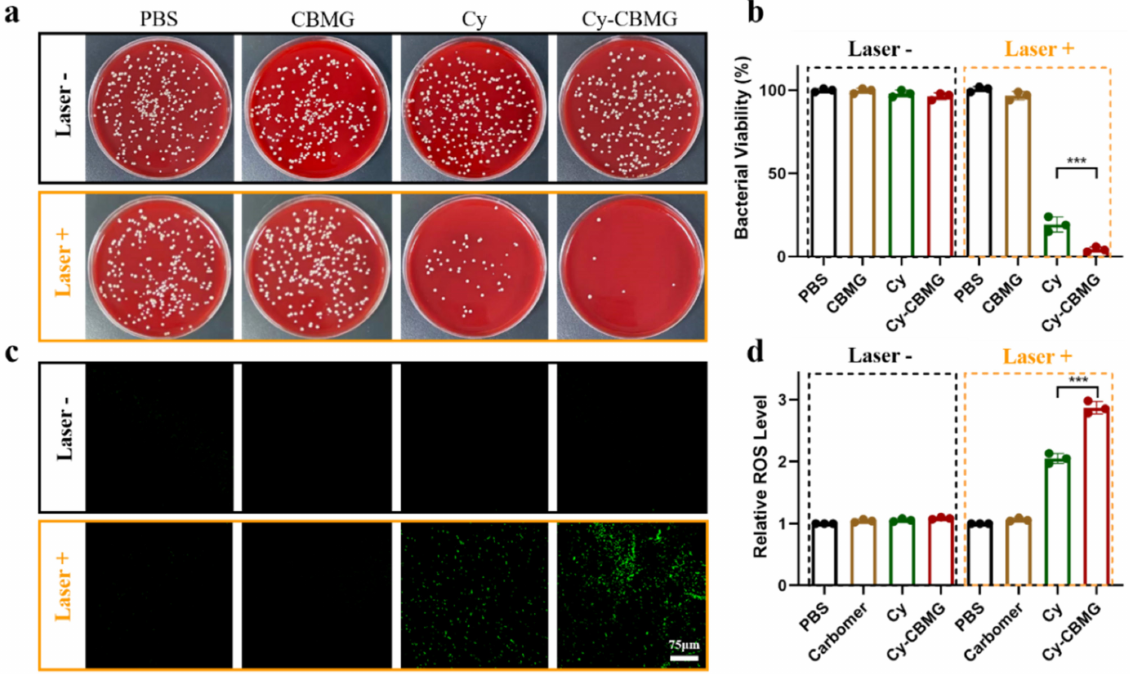
Figure 3. Antibacterial activities of different treatments in vitro. ( a ) CFUs of MRSA on plates after various treatments and with or without laser irradiation (600 nm, 100 mW/cm 2 ). ( b ) Bacterial viability analysis based on CFUs. ( c ) Confocal images of bacterial intracellular ROS fluorescence intensity. ( d ) The relative ROS level detected by a microplate reader (488/525 nm). ***: a statistically significant difference between groups, p <